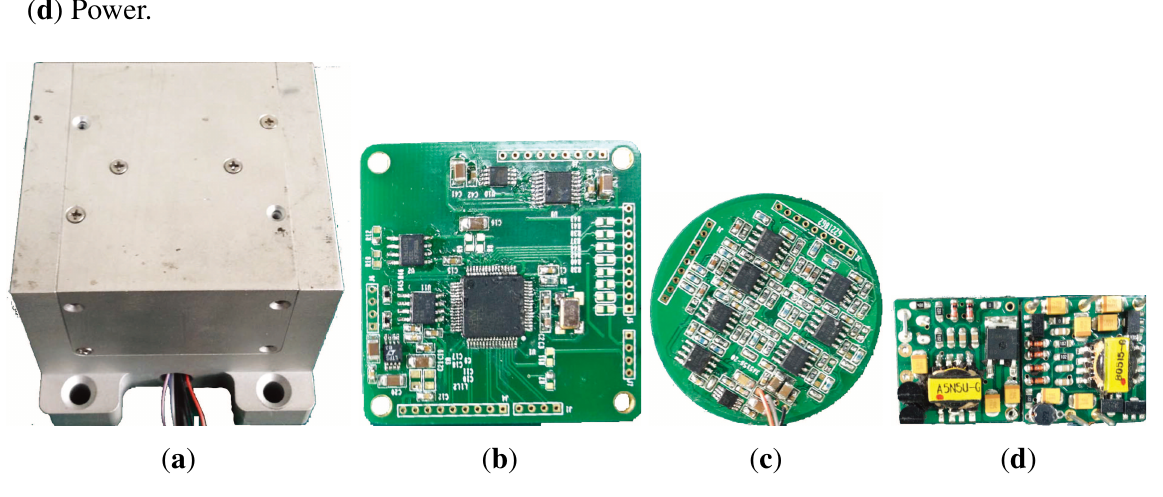
Figure 18. The photo of circuit. ( a ) Gyro chassis; ( b ) signal processing; ( c ) signal sample; ( d )